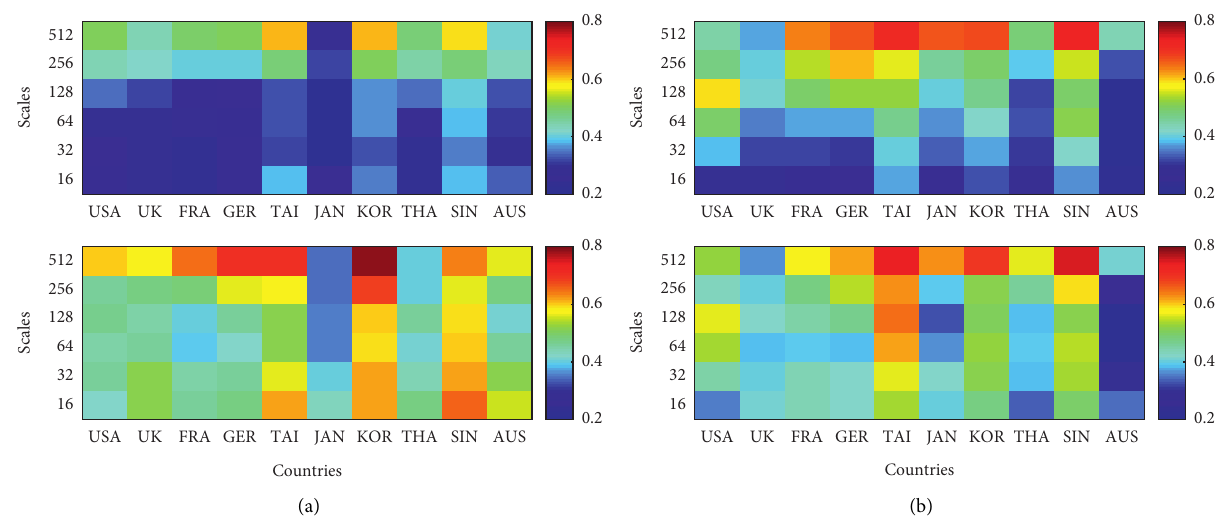
Figure 2: Cross-correlation coefficients matrix between AHA, AHH, and other ten stock indices pairs for the preperiod (a) and the postperiod (b). Note: this figure shows the variations of multifractal cross-correlation exponents; in each subplot, the higher one shows the coefficients of AHA with the other ten pairs and the lower one exhibits the AHH’s. We quantify the ρ 32, 64, 128, 256, and 512